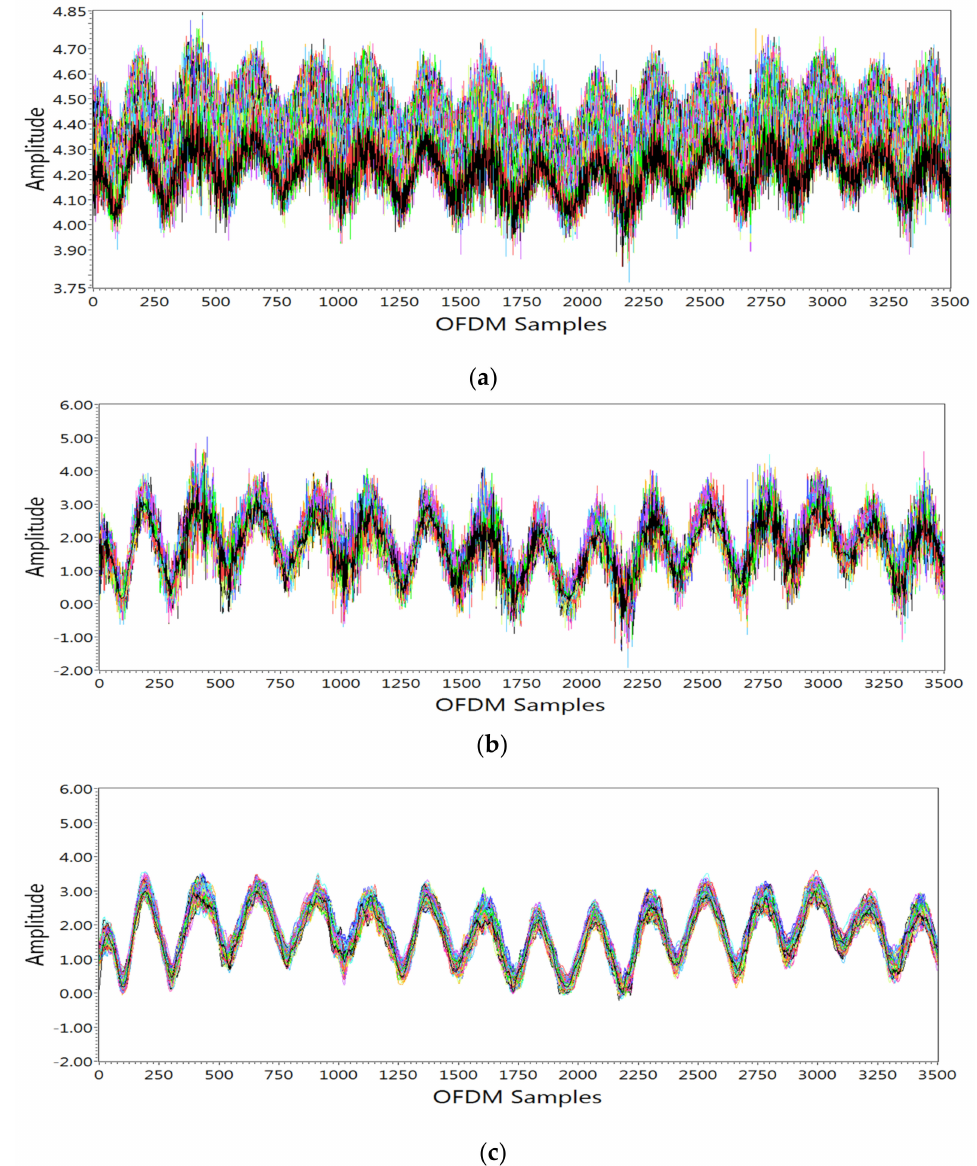
Figure 4. Breathing data processing: ( a ) data after subcarrier selection; ( b ) data after outlier removal; ( c ) data after